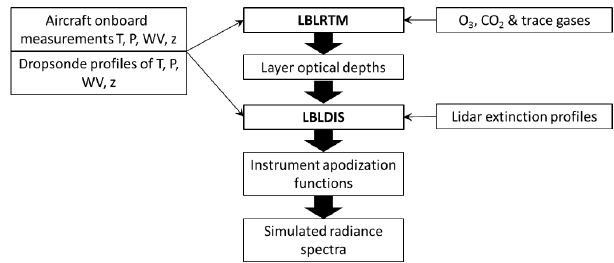
Figure 4. Schematic of the inputs ( T denotes temperature, P de- notes pressure, WV denotes water vapour and z denotes altitude) and steps involved in simulating the radiance spectra observed by the TAFTS and ARIES spectrometers.